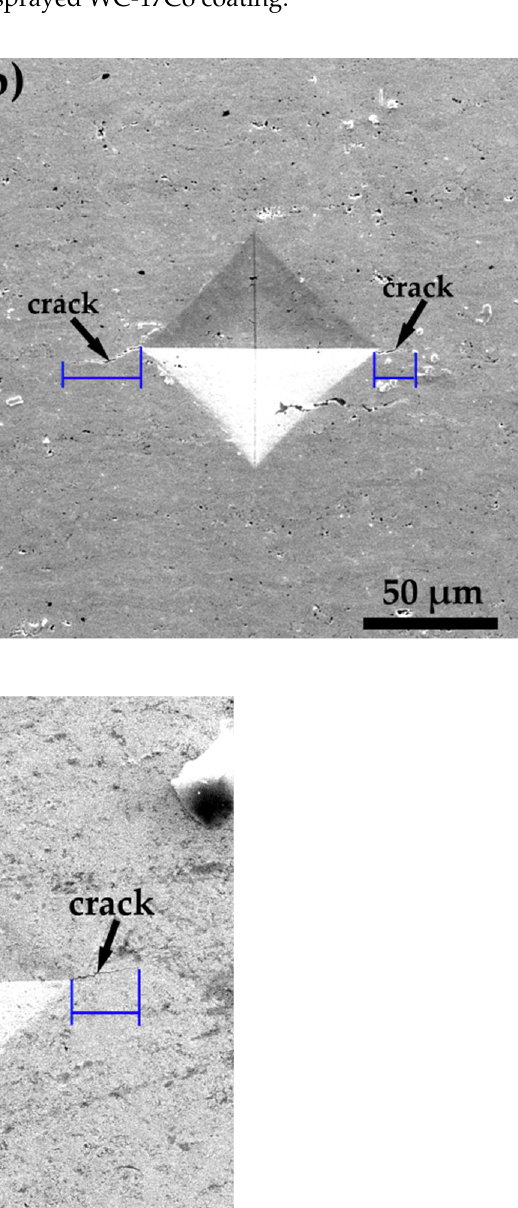
Figure 16. Fracture toughness of WC-17 coatings formed by various spraying methods.